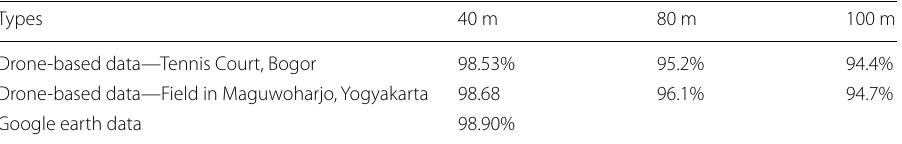
Table 1 Experimental result for mapping with the drone and calculating area of an outdoor tennis court and field in Maguwo compared with google earth